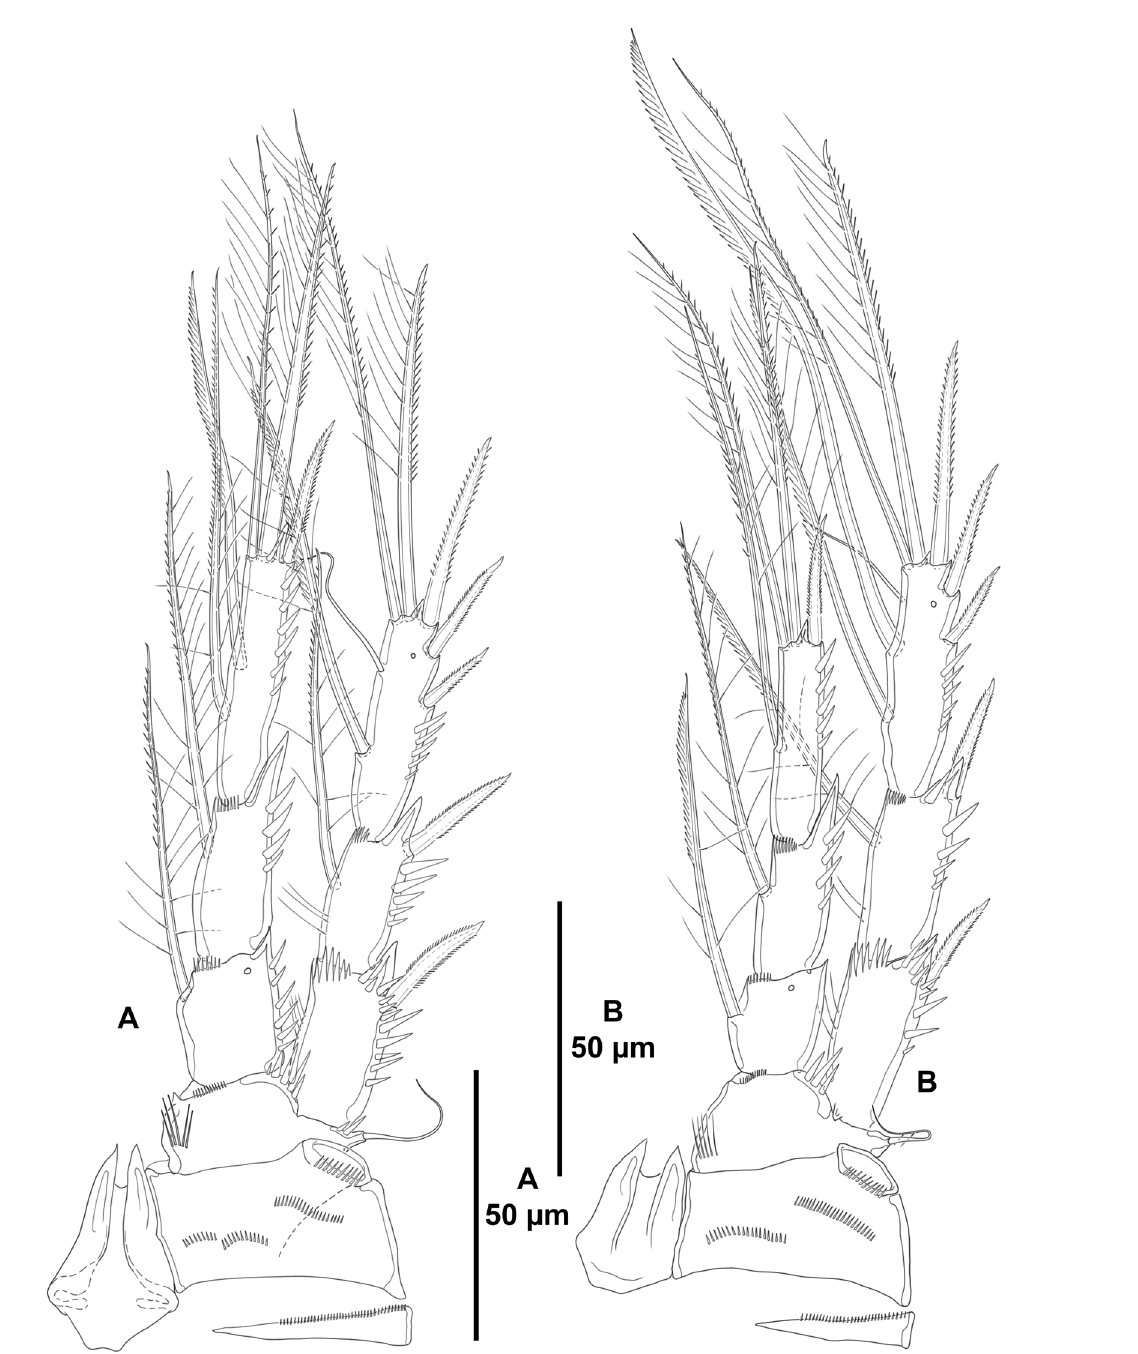
Fig. 16. Spinodiosaccus primus gen. et sp. nov., paratype, ♀ (ICML-EMUCOP-180119-65). A . P3, anterior view. B . P4, anterior